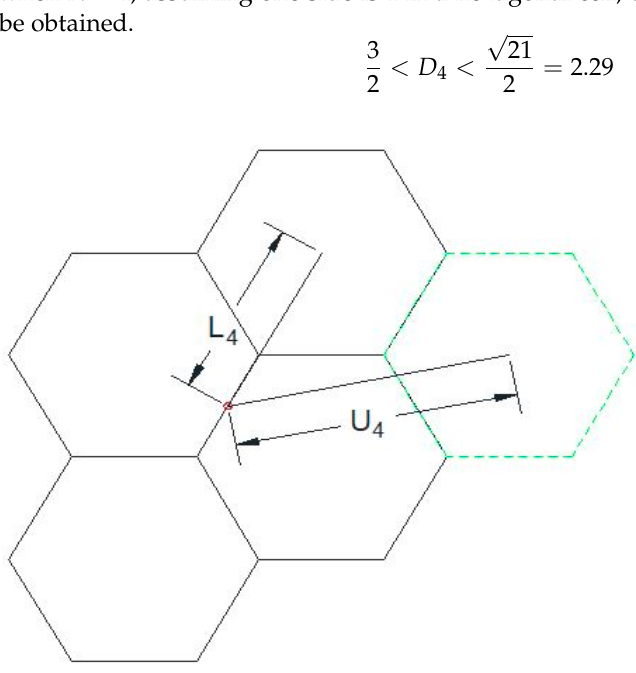
Figure 3. Lower bound and upper bound of reference distance ( N = 4).